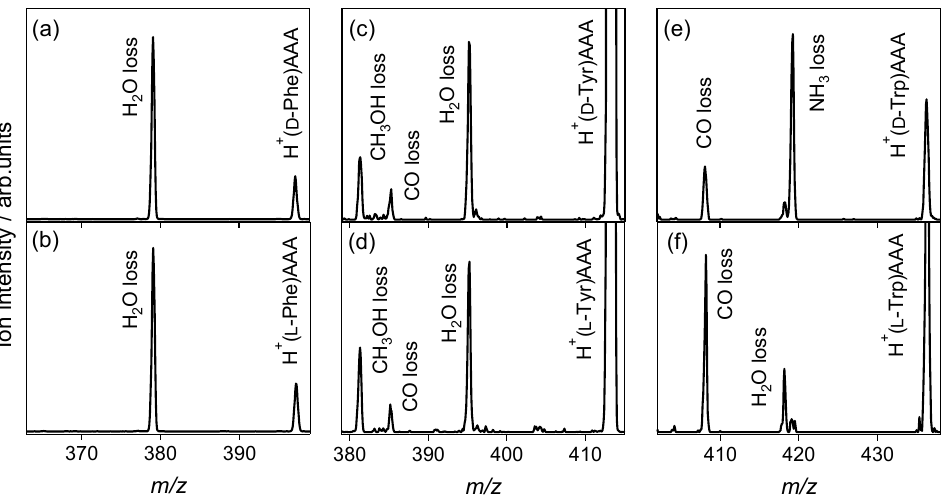
Figure 1. Collision-activated dissociation spectra of protonated noncovalent complexes of aromatic amino acids with L -alanine tripeptide: ( a ) H + ( D -Phe)AAA, ( b ) H + ( L -Phe)AAA, ( c ) H + ( D -Tyr)AAA, ( d ) H + ( L -Tyr)AAA, ( e ) H + ( D -Trp)AAA, and ( f ) H + ( L -Trp)AAA.